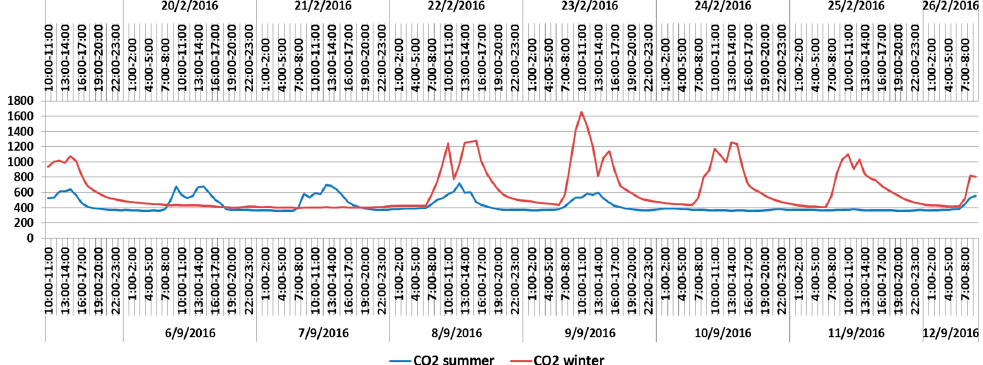
Figure 8. CO 2 levels of Building A, during winter and summer monitoring.